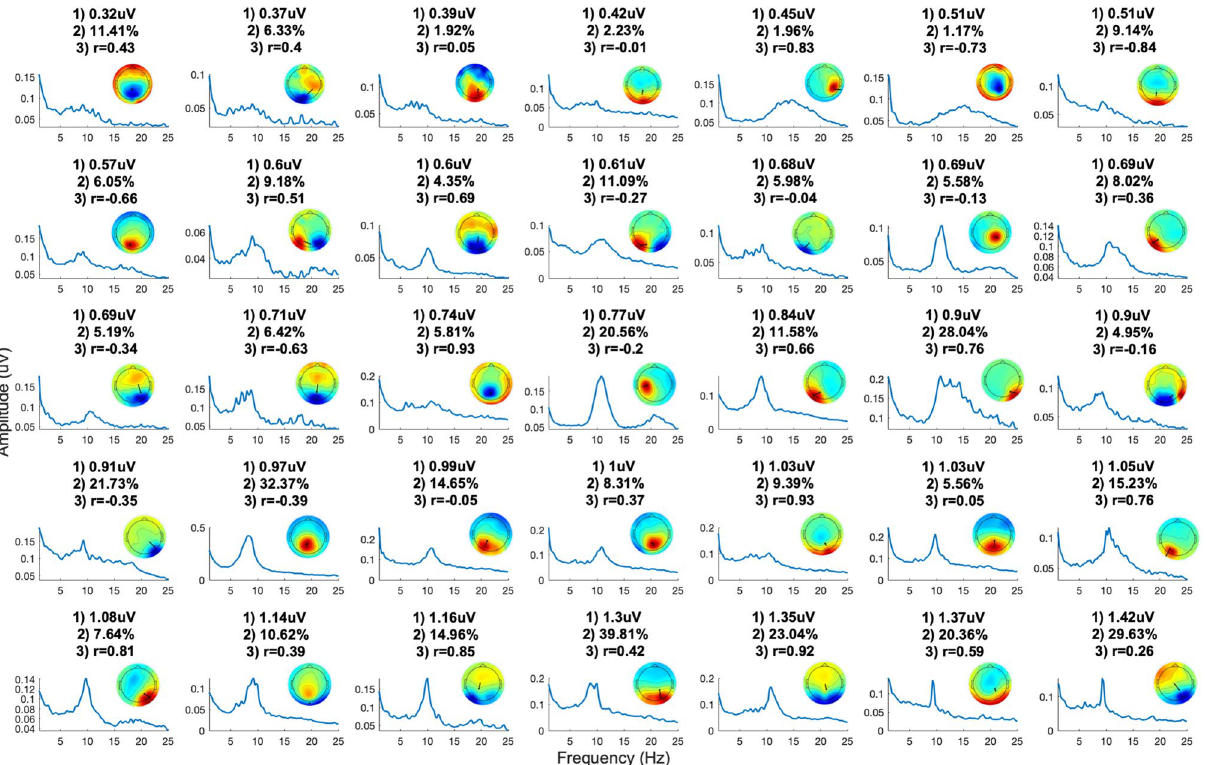
Figure 3. Chosen component characteristics. Power spectra and weights are plotted across all chosen components. Each component is plotted with details of (1) resting state amplitude of the power spectral peak at the IAF; (2) percentage variance in the raw data accounted for by the component; (3) the amplitude-distance correlation coefficient. Components are ordered by increasing resting state amplitude at the